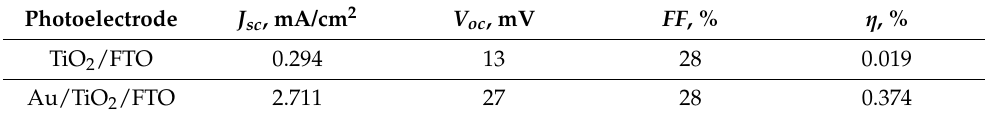
Table 1. Photovoltaic characteristics of the photoelectrodes under study.